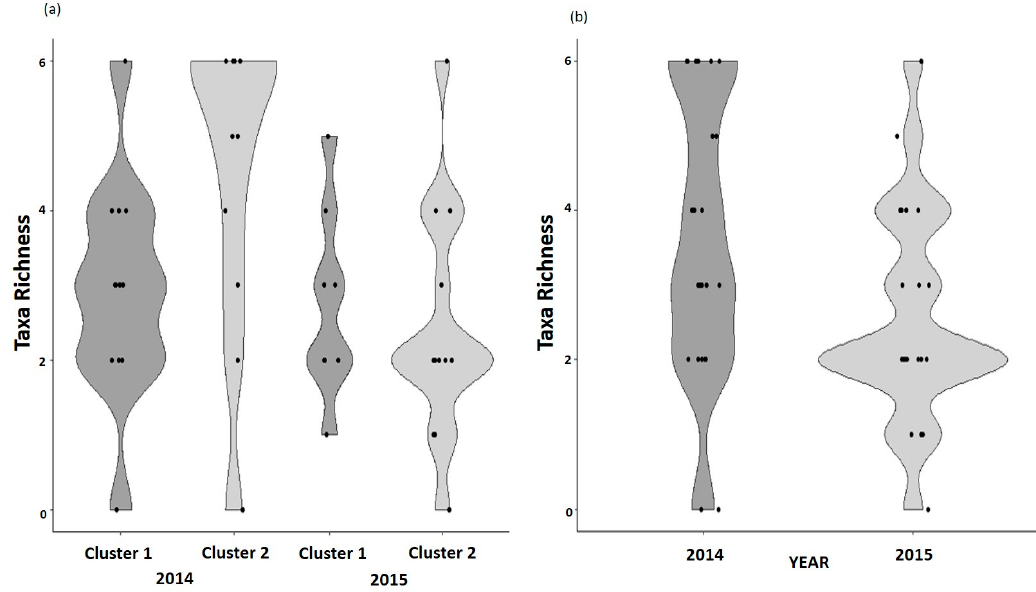
Figure 3. The panel ( a ) reports the violin plot of Cluster 1 (dark grey) and Cluster 2 (light grey) taxa richness relative to the years 2014–2015. The panel ( b ) reports the violin plot of taxa richness in the pooled clusters in 2014 (dark grey) and in 2015 (light grey).